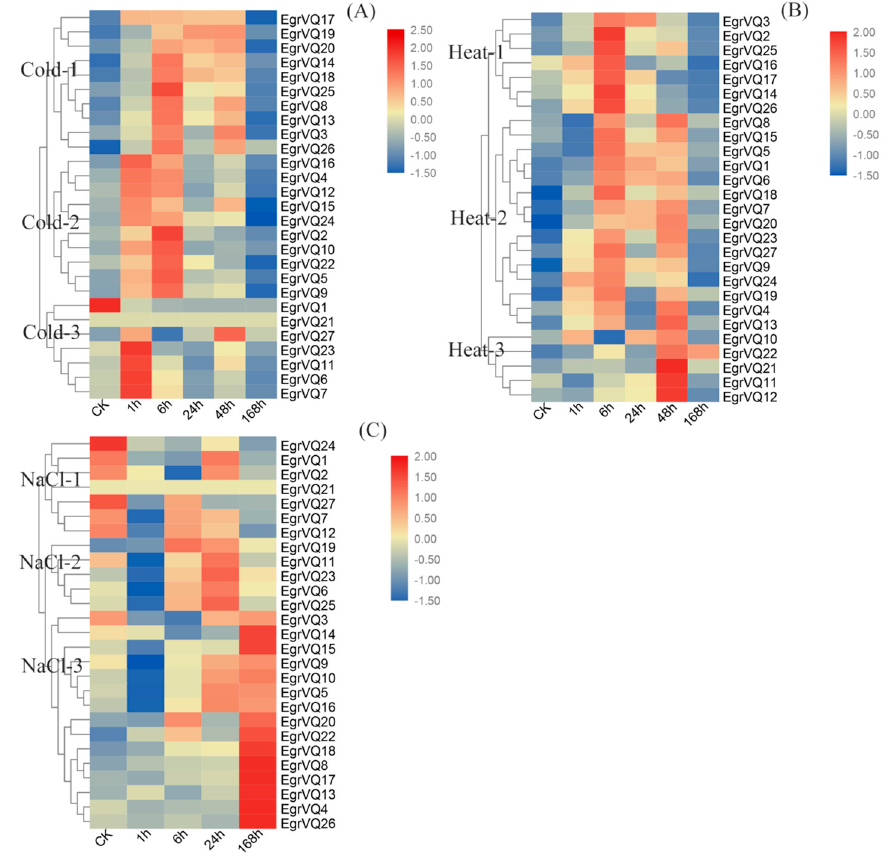
Figure 8. Expression analysis of 25 EgrVQ genes in E. grandis following cold ( A ), heat ( B ), and NaCl ( C ) treatments, as determined by qRT-PCR. The relative expression levels were calculated using the 2 − ∆∆ Ct method. The heatmap was created using MEV.